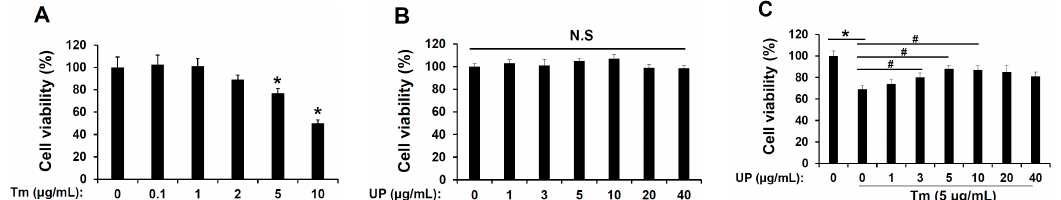
Figure 1. Role of Undaria pinnatifida (UP) in endoplasmic reticulum (ER) stress-induced cytotoxicity in the GT1-7 cells. ( A ) GT1-7 cells were treated with tunicamycin (0.1–10 μ g/mL) for 24 h, and then cell viabilities were measured with MTT assay. The results are means ± SD ( n = 3); * p values of <0.05 indicate significantly different from treatments without tunicamycin; ( B ) The GT1-7 cells were treated with UP (1–40 μ g/mL) for 24 h, and then cell viabilities were measured with MTT assay. The results are means ± SD ( n = 3); ( C ) The GT1-7 cells were treated with tunicamycin (5 μ g/mL) for 24 h with UP (1–40 μ g/mL), and then cell viabilities were measured with MTT assay. The results are means ± SDs ( n = 3); * p values of <0.05 indicate significantly different from treatments without tunicamycin. # p values of <0.05 indicate significantly different from treatments with tunicamycin alone.